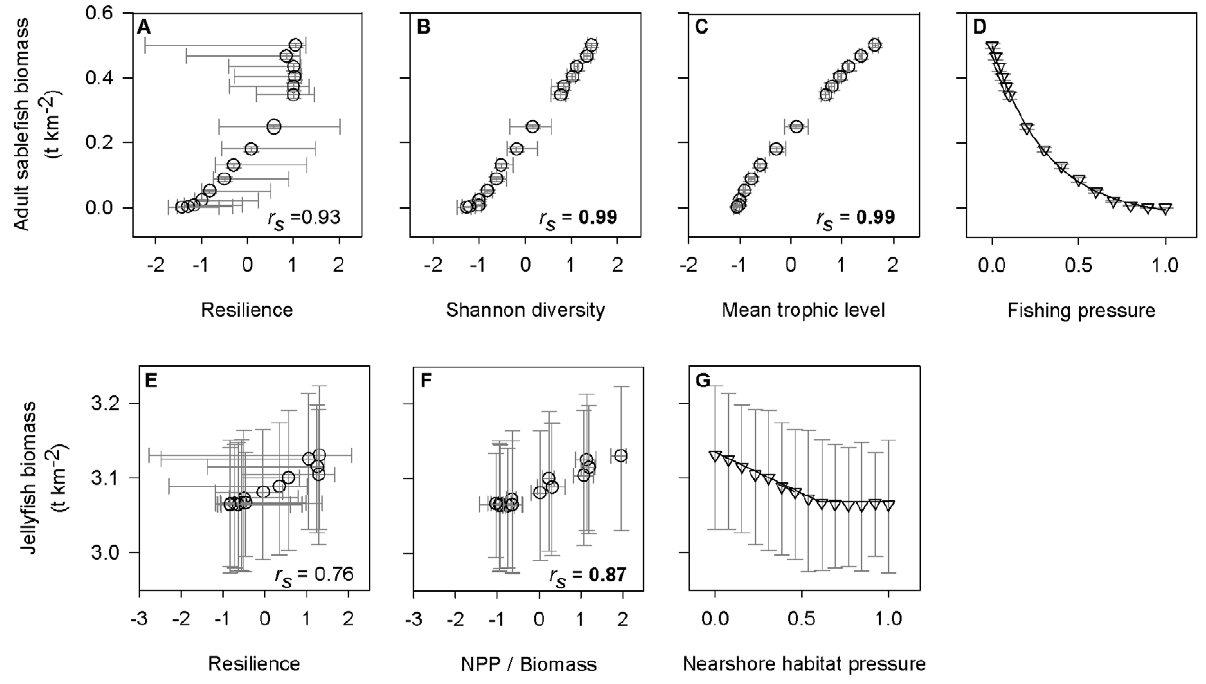
Figure 3. Correlations between indicators and attributes with significant utility thresholds, along with indicator-pressure relationships. The indicators are sablefish and jellyfish biomass for the fishing (a-d) and nearshore habitat (e-g) pressure simulations, respectively. Open circles (a-c, e-f) and triangles (d, g) indicate median values calculated from Monte Carlo simulated Ecopath with Ecosim data ( n =100 for each pressure level), and error bars denote 95% confidence intervals. The solid lines in (d) and (g) represent best-fit functional relationships estimated using a nonparametric bootstrap resampling procedure ( n =10,000 for each Monte Carlo data set) (parameter values listed in Table 3). r s =median spearman rank correlation across the Monte Carlo data sets (bold indicates 95% CI did not overlap zero), NPP=net primary production.